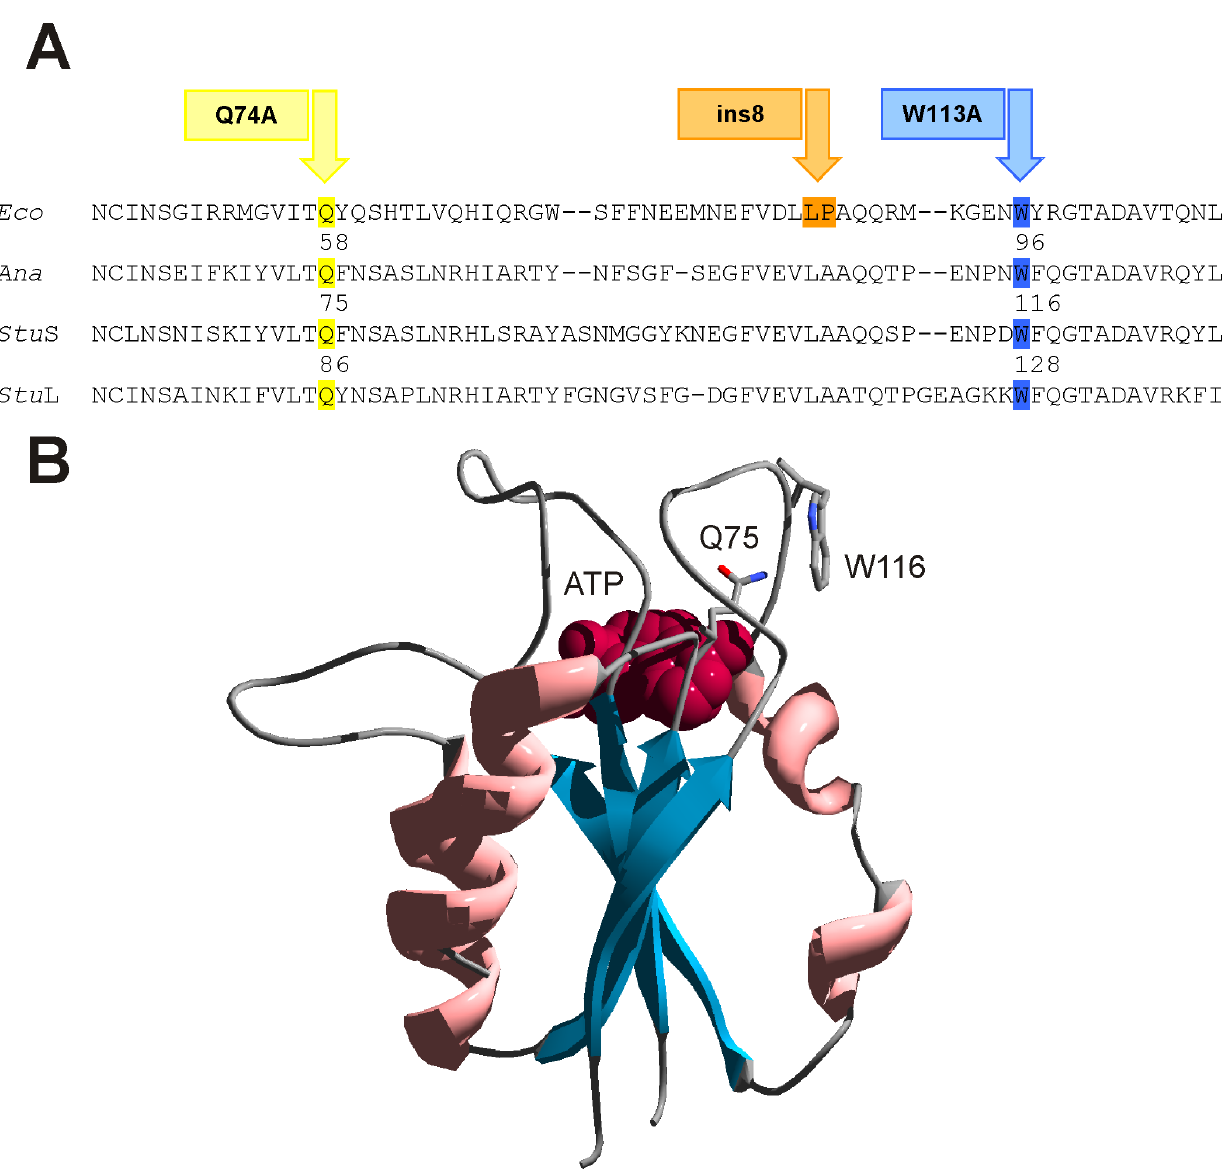
Figure 1. Identification of amino acids important for 3-PGA activation. A. Sequence alignment of ADP-Glc PPases from Escherichia coli ( Eco ), Anabaena PCC 7120 ( Ana ), and potato tuber ( Stu S: small subunit, Stu L: large subunit). Mutants of the E. coli enzyme that were insensible to Fru-1,6- bisP activation [19] are pointed with arrows. Residues that might be involved in 3-PGA activation of ADP-Glc PPases from Anabaena and potato tuber are highlighted in yellow (Gln) and blue (Trp). B. Insight into the three-dimensional structure of the N-terminal domain (residues 20 to 144) from Stu S. Residues Q75 and W116 are shown as ‘‘sticks’’ and colored by atom type. ATP is shown in red as van der Waals radii. Loops are colored in grey, a - helices in pink, and b -helices in